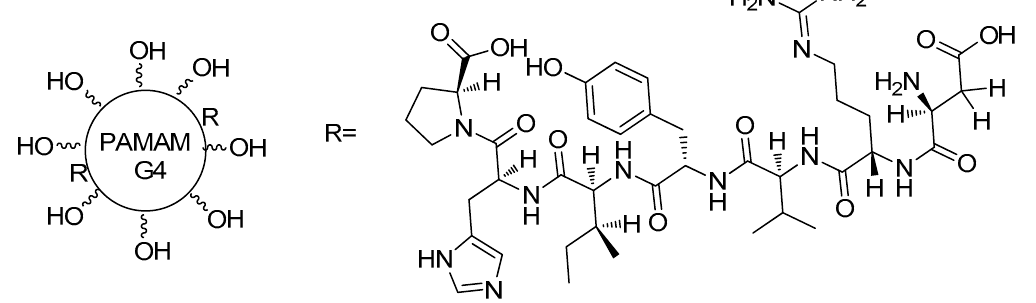
Figure 5. Structure of the PAMAM-G4-OH-Ang-(1-7) compound [58].